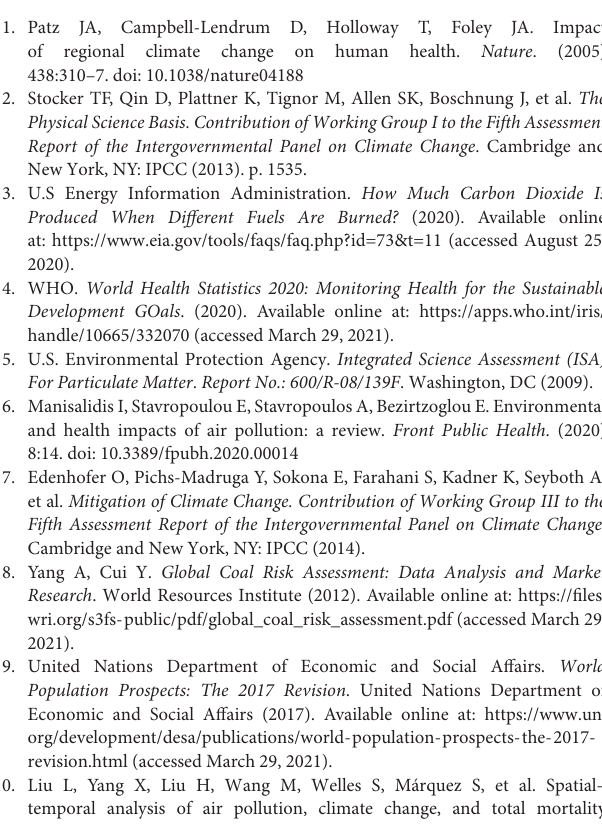
100%, 100%, replaced by replaced by renewables natural gas